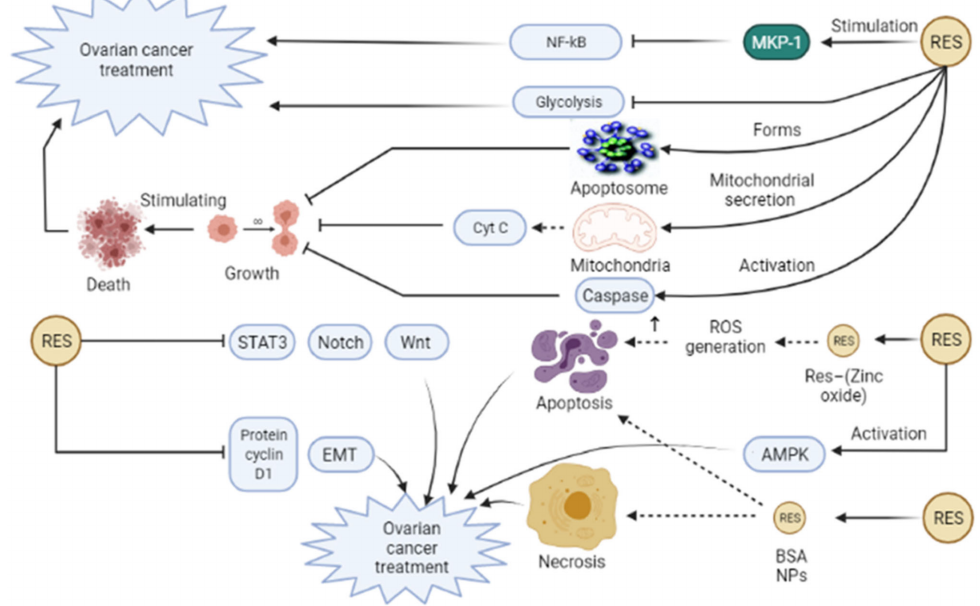
Figure 4. Resveratrol (Res) can trigger various mechanisms involved in ovarian cancer treatment. Res can stimulate mitogen-activated protein (MAP) kinase phosphatase-1 (MKP-1) that leads to inhibition of NF-kB pathway and subsequently contributes to inflammation suppression and ovarian cancer improvement. Furthermore, the administration of Res can stimulate apoptosome complex formation, caspase activation, and mitochondrial secretion of cytochrome c, which all end in inhibition of growth and stimulation of cell death. In addition, Res suppresses glycolysis in ovarian cancer cells that can be effective in ovarian cancer treatment. Res can act against ovarian cancer through AMPK activation, downregulation of the protein cyclin D1, and inhibition of EMT, STAT3, Notch, and Wnt signaling pathways, leading to ovarian cancer treatment. Moreover, consumption of Res—(Zinc oxide) ZnO nanohybrid can lead to the generation of ROS in ovarian cancer cell lines and exert anti-cancer effects on ovarian cancer. In addition, Res–bovine serum albumin (BSA) NPs induce ovarian cancer cell necrosis and cellular apoptosis, attenuating tumor growth in ovarian cancer. EMT, Epithelial–mesenchymal transition; Cyst C, Cytochrome c; STAT3, Signal transducer, and activator of transcription 3; NF-kB, Nuclear